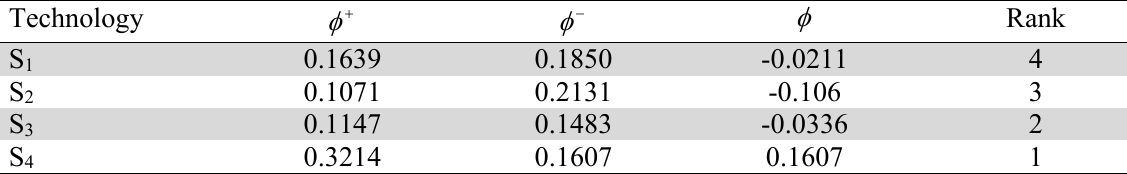
PROMETHEE outputs for the EST ranking